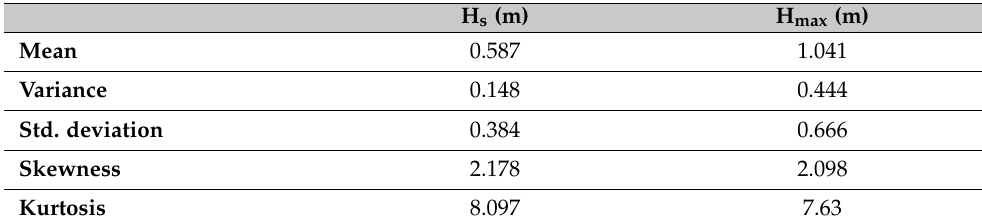
Table 3. A simple statistical analysis of the 30-min averaged CDIP Egmont Key (FL, USA) buoy data from June 2015 to December 2019.